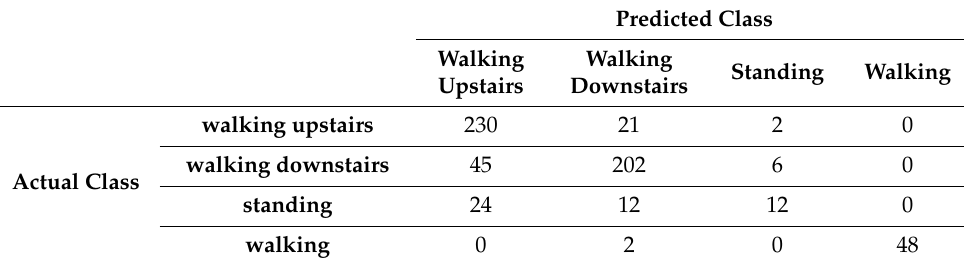
Table 10. Confusion matrix for non-normalized gyroscope data.